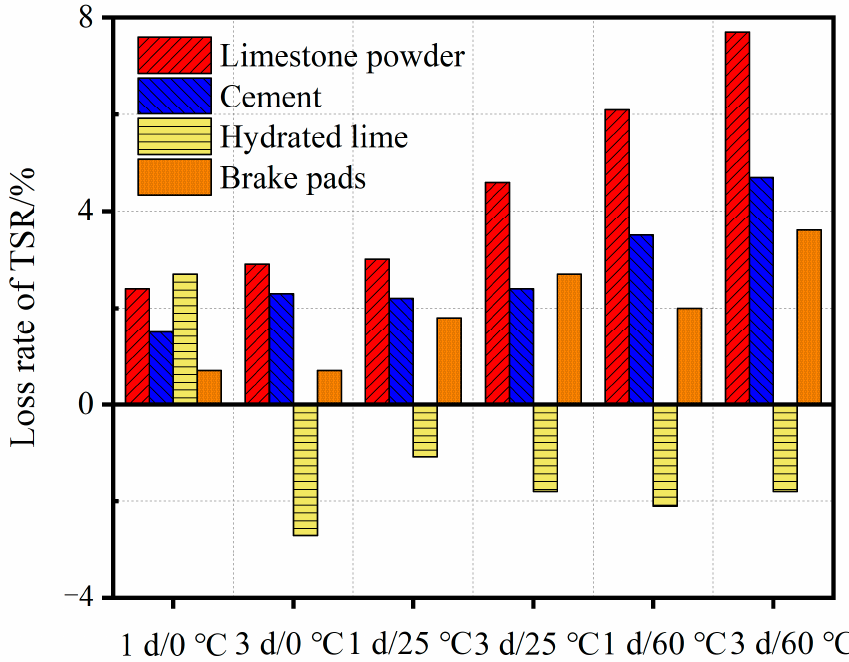
Figure 5. TSR loss rate of the asphalt mixtures after water saturation.